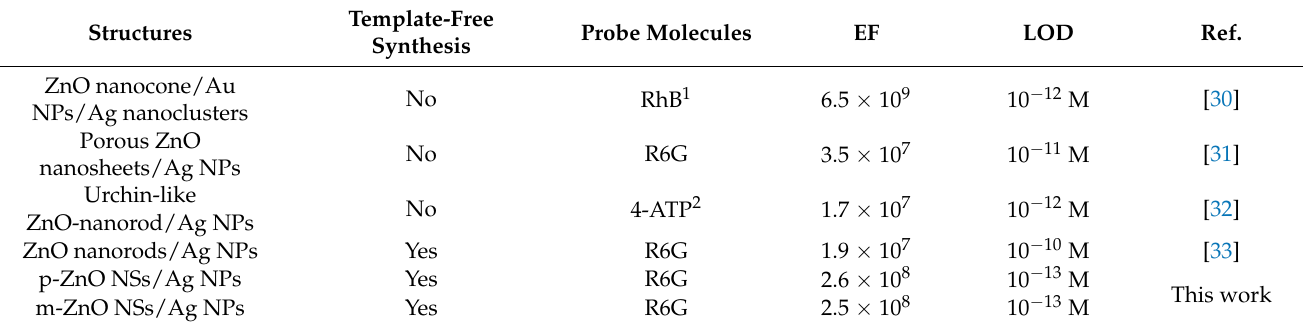
Raman performance of recent typical SERS substrates based on the combination of ZnO micro/nanostructures and noble metal nanoparticles (RhB 1 is Rhodamine B; 4-ATP 2 is